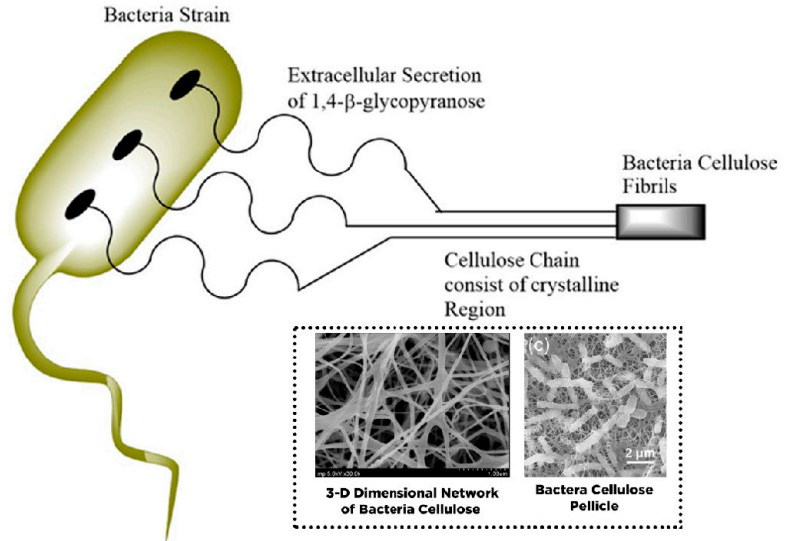
Figure 10. Diagrammatic representation of preparation of bacteria cellulose by means of extracellular secretion (SEM) images of three-dimensional network of bacteria cellulose, TEM images of BC pellicle. Reproduced from Lunardi and team [154].